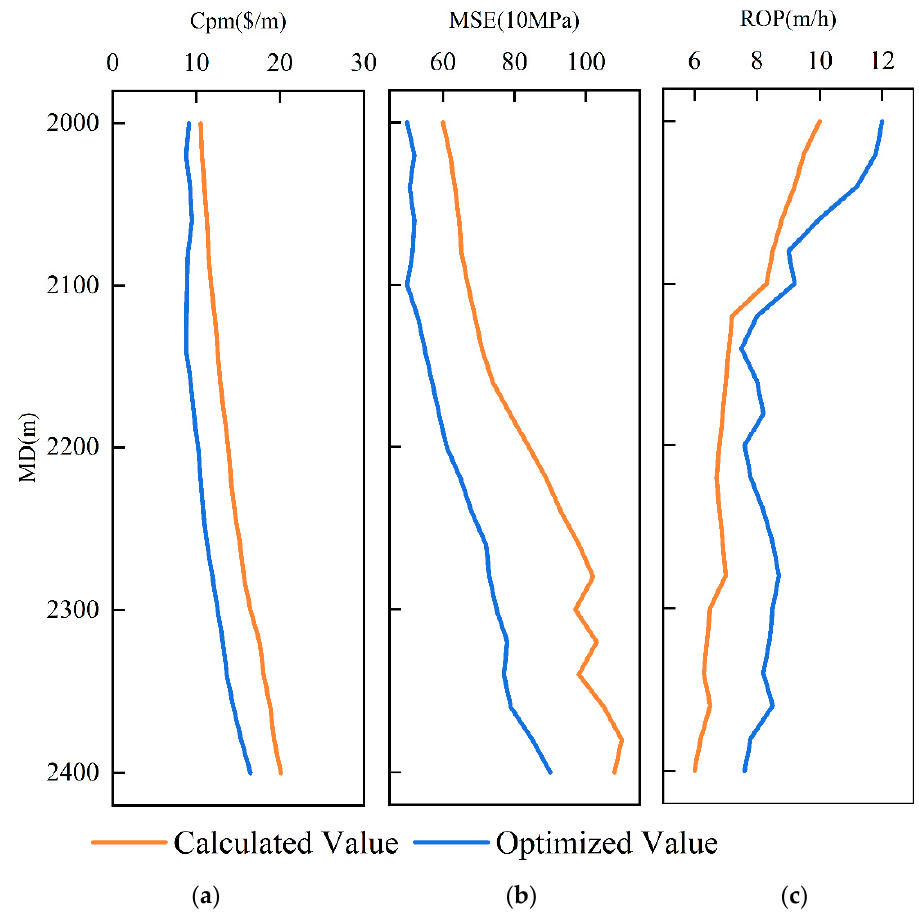
Figure 4. Comparison of (cid:1829) (cid:3043)(cid:3040) , MSE, and ROP results before and after optimization